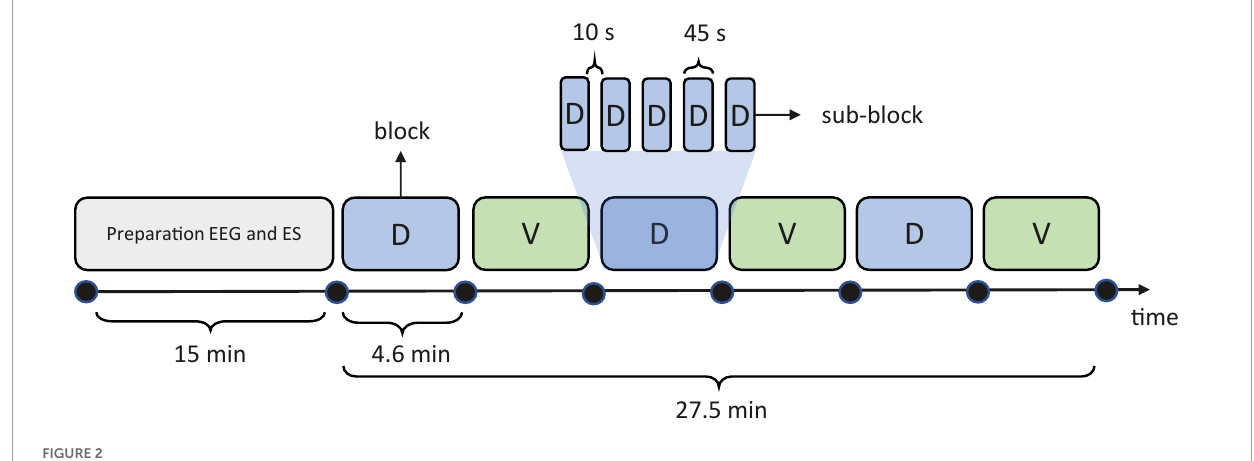
FIGURE2 Timeline of the test depicting the durations of experimental phases (blocks). Colored shapes (light blue and light green) represent the 6 experimental blocks in which the subjects attended the stimuli delivered at D and V locations, respectively. One example of division of a single D block into 5 sub-blocks is presented